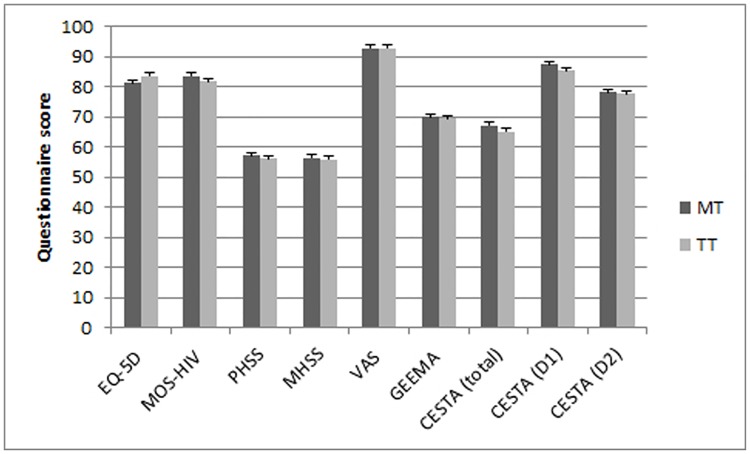
Final scores (mean values at week 24 with error bars showing 95% confidence intervals) of the 5 questionnaires evaluating the quality of life of both groups.